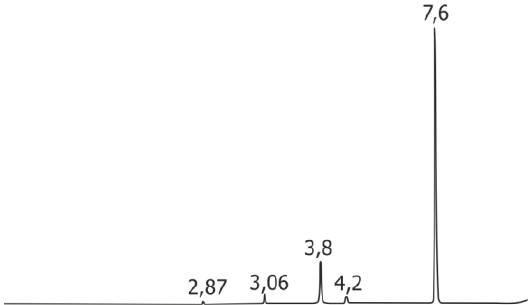
Figure 5. Results of X-ray diffractions.